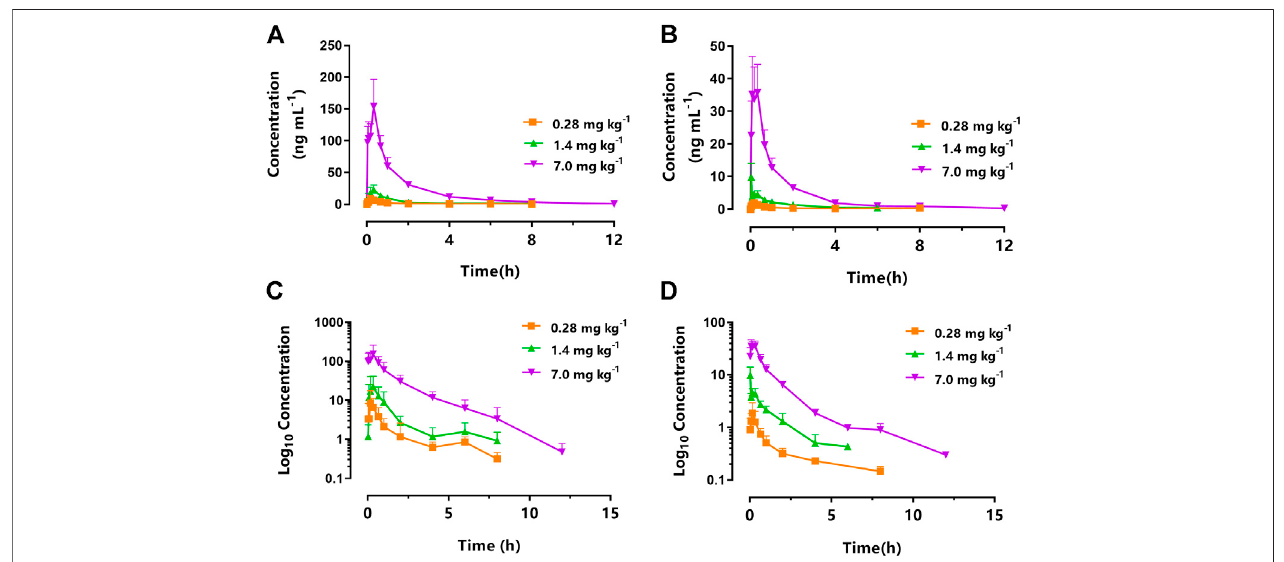
FIGURE 3 | Mean plasma concentration-time curve of koumine (KM) following intragastric administration of 0.28 mg kg − 1 (squares), 1.4 mg kg − 1 (triangles), and 7.0 mg kg − 1 (inverted triangles) to (A) rats with streptozotocin (STZ)-induced diabetic neuropathic pain or (B) naïve rats. The corresponding log 10 concentration-time curve of koumine (KM) following intragastric administration of 0.28 mg kg − 1 (squares), 1.4 mg kg − 1 (triangles), and 7.0 mg kg − 1 (inverted triangles) to (C) rats with streptozotocin (STZ)-induced diabetic neuropathic pain or (D) naïve rats ( n (cid:2) 6 per group).